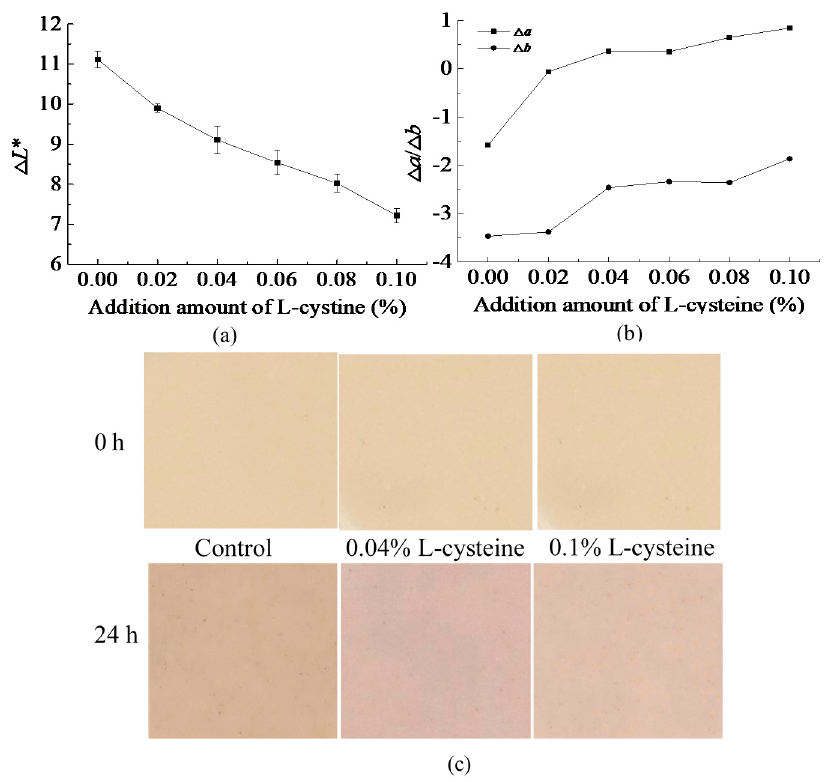
Figure 1. Effect of L-cysteine on the browning of FWN: ( a ) Δ L * of FWN, ( b ) Δ a * / Δ b * of FWN, and ( c ) pictures. The values of a * and b * represented greenness-red and blue-yellowness, respectively. ∆ a *, ∆ b * represented the difference between the initial a *, b * values of the FWN and the a *, b * values of storage for 24 h. If ∆ a *, ∆ b * < 0, it meant that the color of the sample shifted toward red and yellow, respectively, otherwise, it shifts toward green and blue. As shown in Figure 1b, after 24 h storage, ∆ b * < 0. It meant that the color of the FWN shifted toward yellow. With the addition of L-cysteine, ∆ b * gradually became larger and was close to zero during 24 h storage, indicating that the color of FWN shifted less toward yellow and the change of yellowness in FWN was reduced. For control, ∆ a * > 0, the color of the sample shifted toward red after 24 h. As the addition amount of L-cysteine increased, the ∆ a * also increased. It meant that the color of FWN shifted less toward red, tending to shift toward green. PPO played an important role in food browning. Bayindirli reported that L-cysteine could be an effective anti-browning agent of Amasya apple juice due to the ability of inhibition of PPO activity [16]. It was speculated that the effect of cysteine on the browning of FWN might be related to PPO